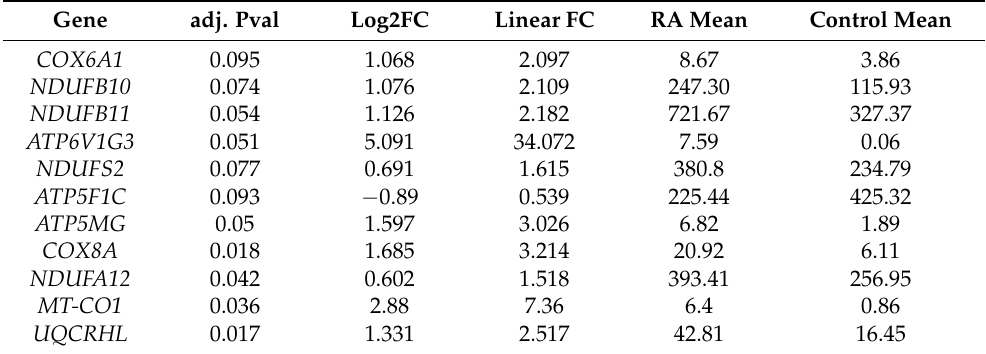
Table 9. Oxidative phosphorylation DEGs in untreated RA CD8 + Tem cells. Means are calculated from DESeq2 normalized counts.